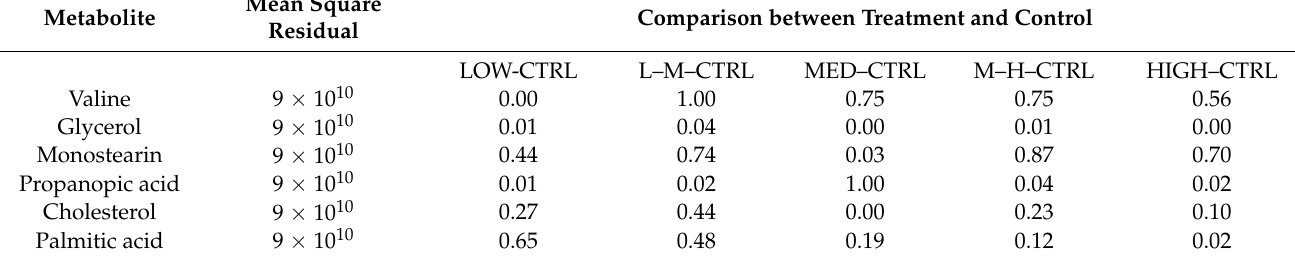
Table 3. Significantly changed metabolites in amphipods following exposure to GenX. Values in bold represent statistical significance following Tukey’s post hoc test. All values listed are